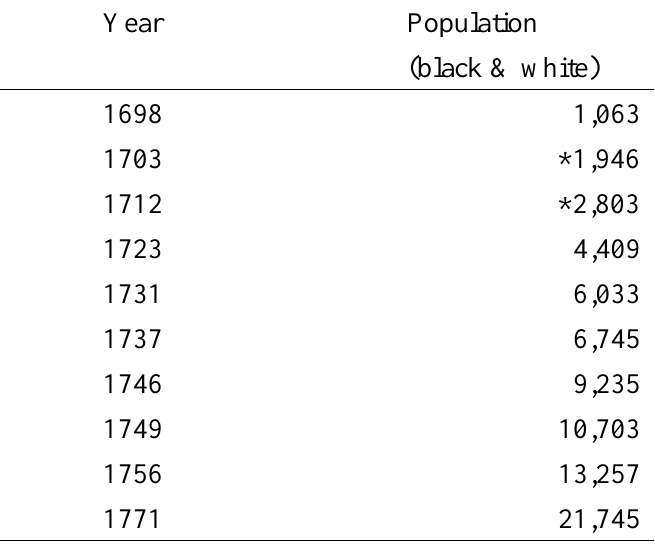
Table 5: Westchester County